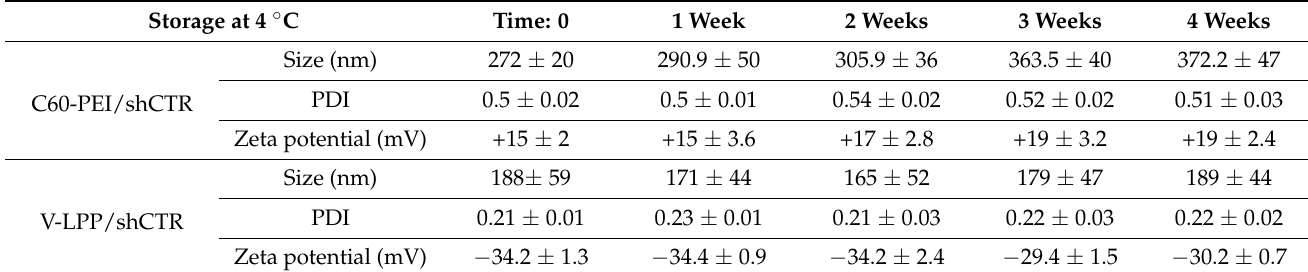
Table 1. Summary of average hydrodynamic diameter, polydispersity indexes (PDI), and ζ -potential of C60-PEI/shCTR polyplexes and V-LPP/shCTR lipopolyplexes at the initial time and after storage at 4 ◦ C for up to one month. Standard deviations correspond to independent measurements ( n = 3).